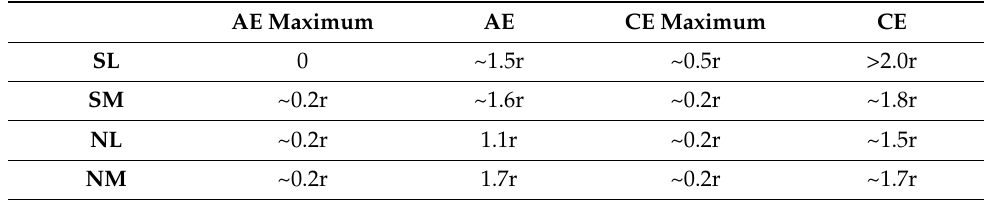
Figure 6. The graph of ZEU′ with normalized radius at different latitudes. The radius interval is 0.1. Table 3. Normalized radius position of the ZEU′ maximum and zero point.